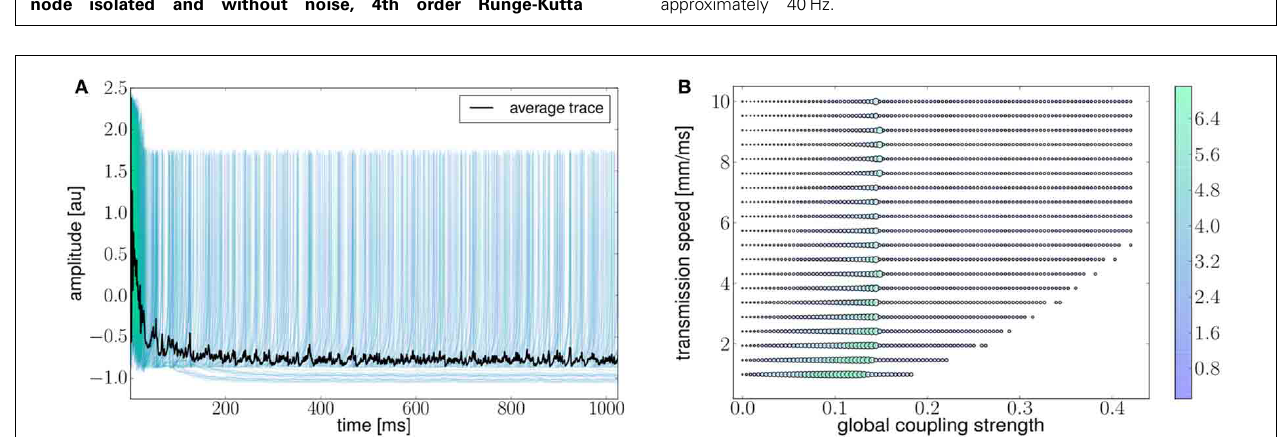
integration scheme. In the bottom panel, the corresponding trajectories of both the v ( t ) and w ( t ) state variables of the model are shown. The activity exhibits oscillations at approximately 40Hz.